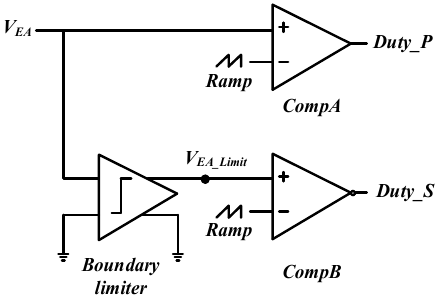
Figure 10. Schematic of the boundary limit control method. Figure 11 shows the switch and control signal under the boundary limit control method. In region I, V EA and V EA_Limit maintain the same voltage because the system reaches